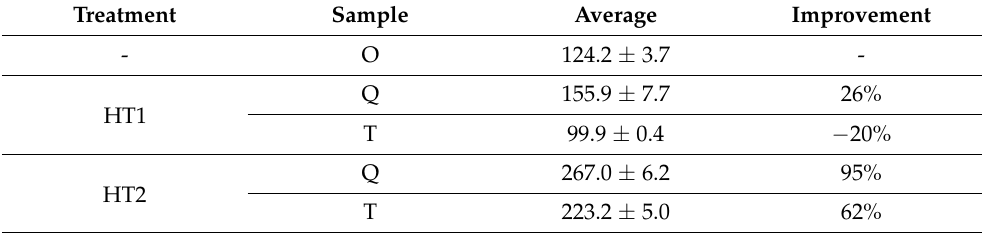
Table 3. Hardness test results for original, quenched, and tempered samples for heat-treatment pro- cedures.